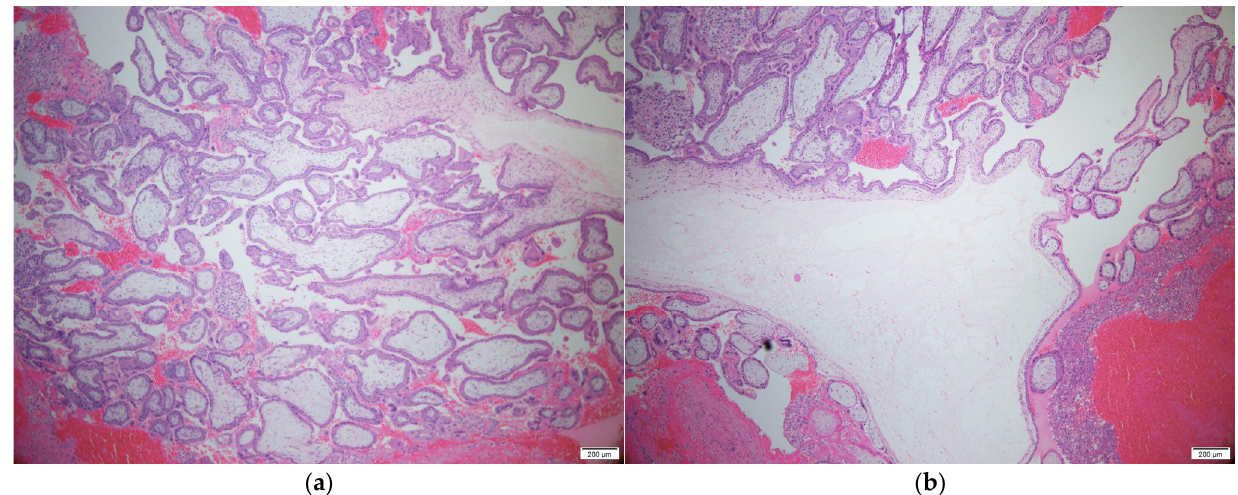
Figure 3. Histopathologic findings: Multiple chorionic villi in the periphery ( a ) and center ( b ) of the diaphragmatic ectopic disc are noted on H&E staining. (×50). Scale bar: 200µm.